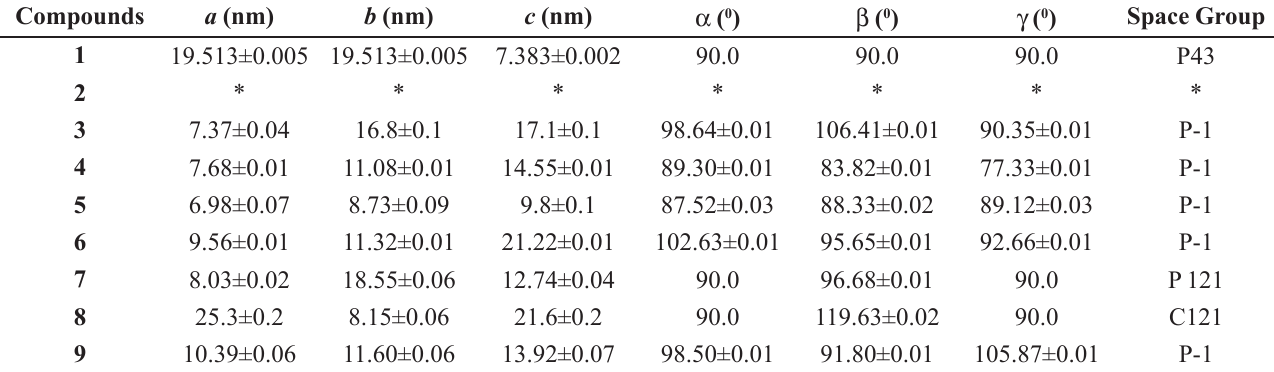
TABLE I - Lupeol ( 1 ) and its esters ( 2 to 9) lattice parameters obtained by Rietveld fitting of the powder X-ray diffraction Compounds